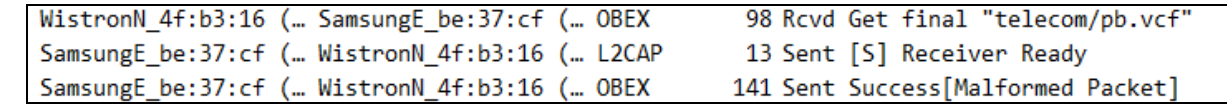
Figure 4. Contact synchronization packets in Android Auto. Table 4. List of Artifacts in Wireless Communication between the IVI and Mobile Device (Android Auto and Apple